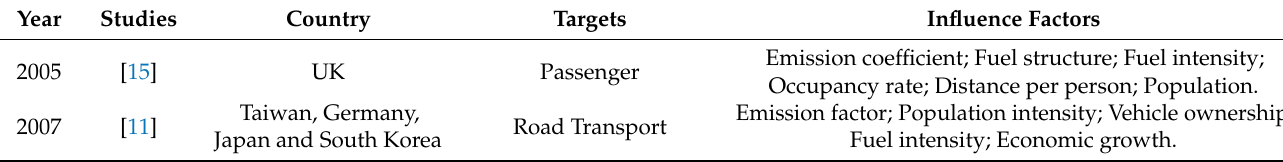
Table 1. A list of studies on investigating the influence factors of road transport